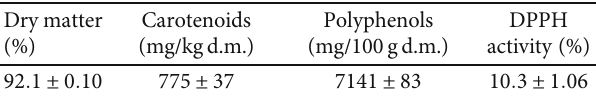
Table 1: Dry matter and selected plant components of sage. Dry